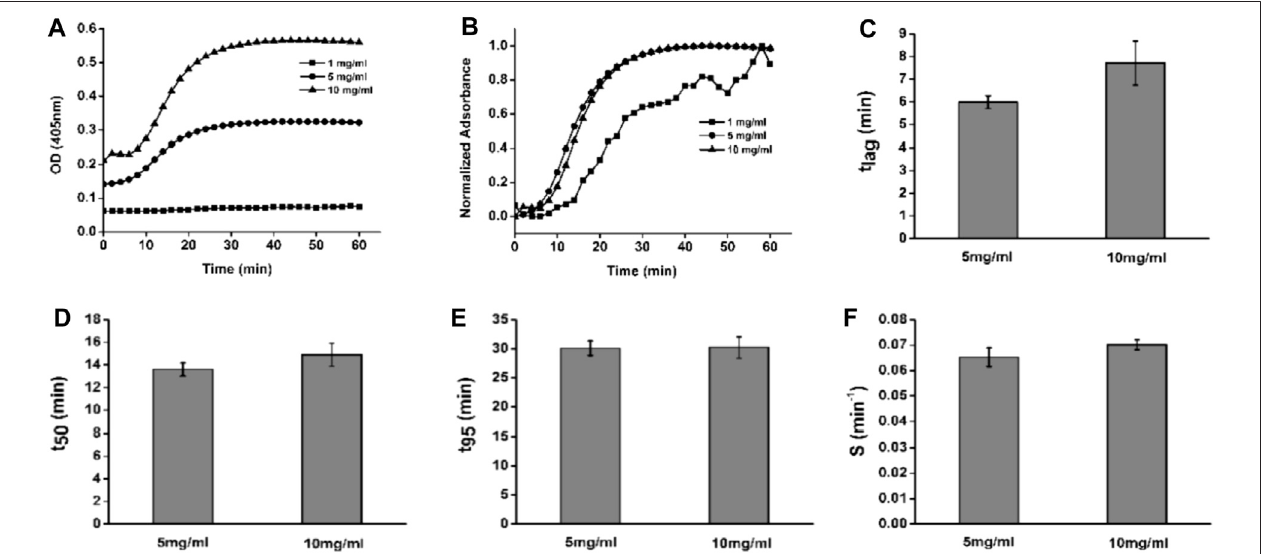
FIGURE 3 | Representative turbidimetric and normalized turbidimetric curves of dcECM hydrogels. (A, B) Turbidimetric (A) and normalized turbidimetric gelation kinetics (B) of dcECM hydrogels at 1, 5, and 10 mg/ml. (C – F) Comparisons of lag time (C) , time to 50% gelation (D) , time to 95% gelation (E) , and speed to complete gelation (F) for 5 and 10 mg/ml dcECM hydrogels. Error bars showed means ± SD, n (cid:2)